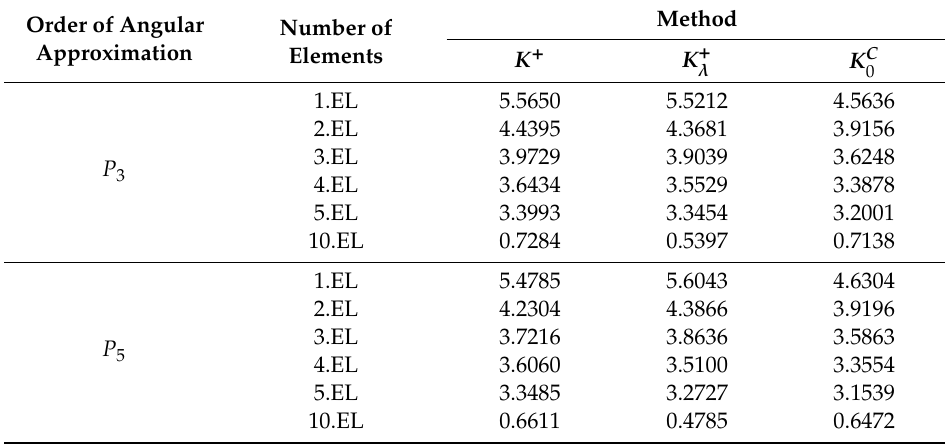
Table 3. Relative errors for P 3 , P 5 approximations with a set of elements for region 2. Order of